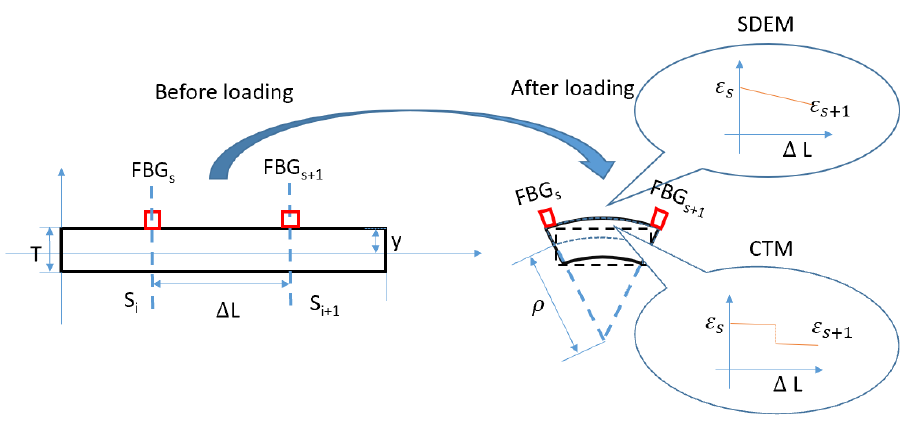
Figure 5. Element before and after loading.